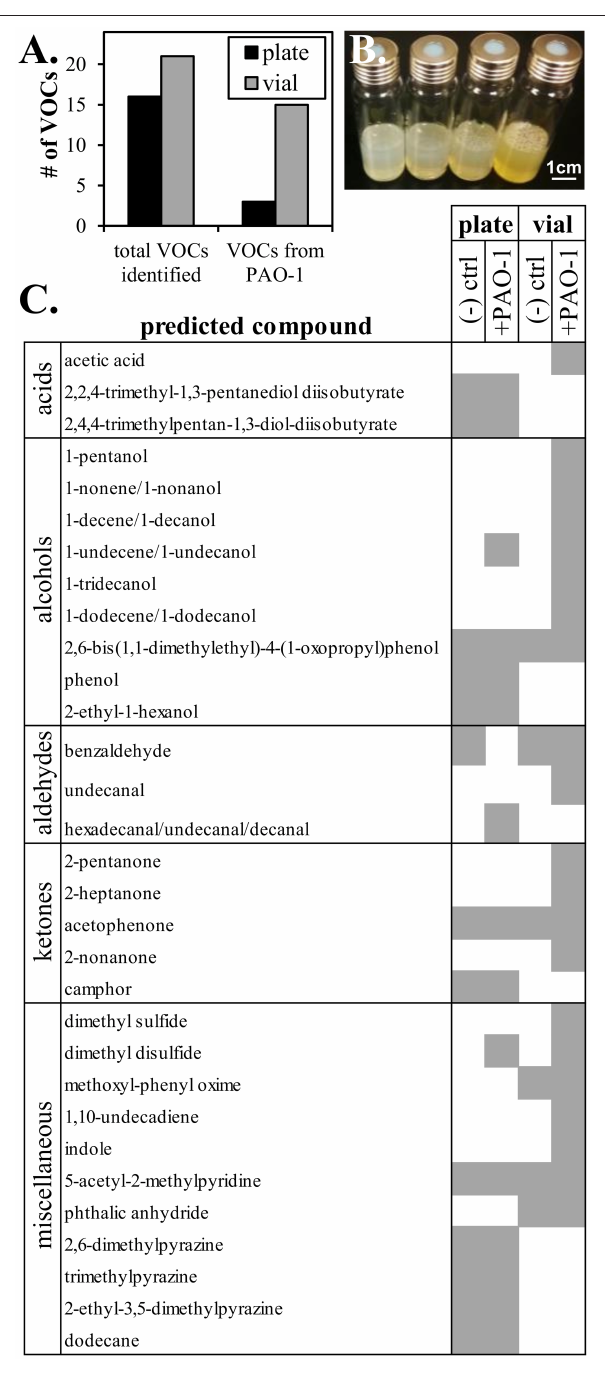
FIGURE 1 | Comparison of current methods with plate based assay for VOC detection. (A) Count of peaks identified by plate (traditional) or vial (current) sampling method for VOC detection. (B) Headspace vials with agar media and growth of PAO1. Scale bar represents 1cm. (C) Summary of